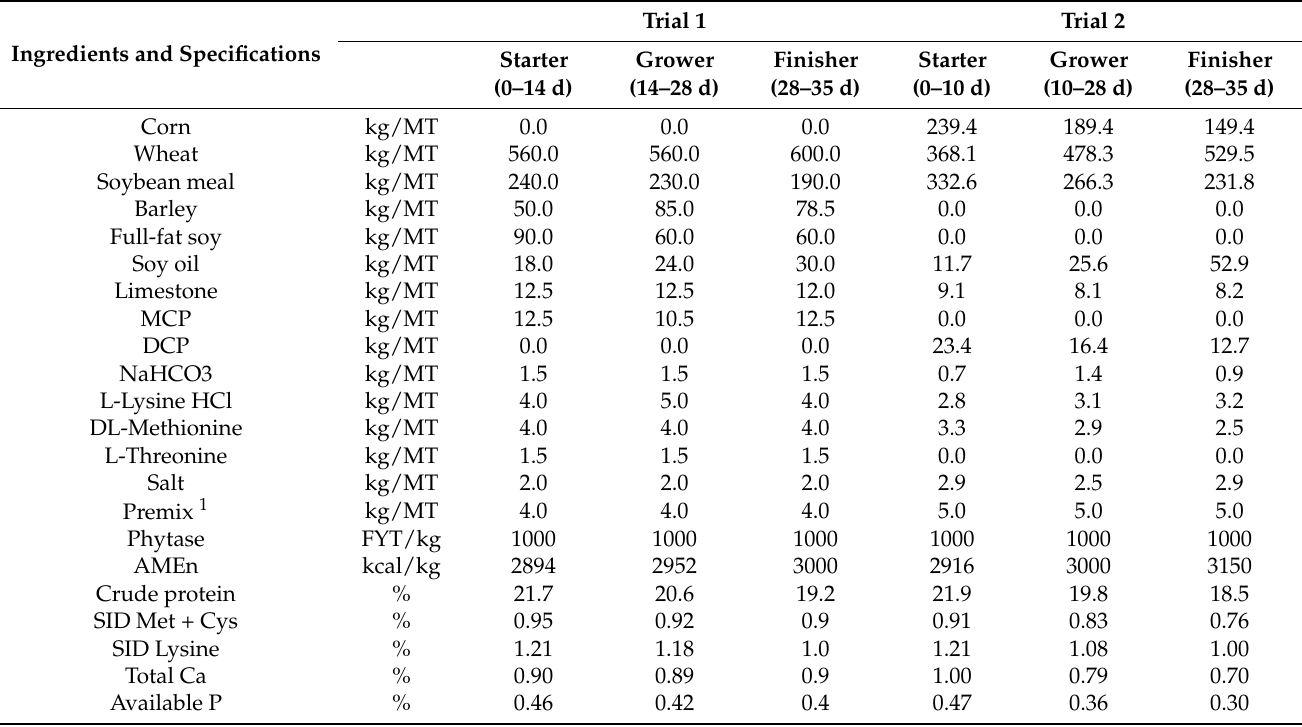
Table 1. Ingredient composition and nutritional specifications of experimental diets of two pen trials with broiler